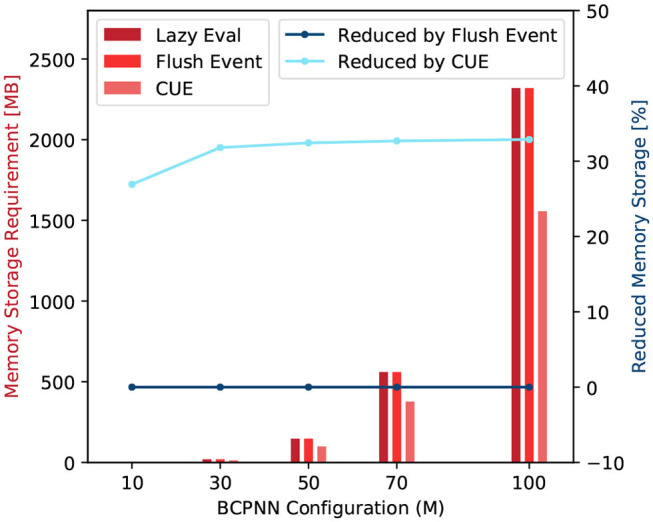
Memory storage requirement comparison (red) and requirement reduction by the flushing event method and the CUE method (blue).